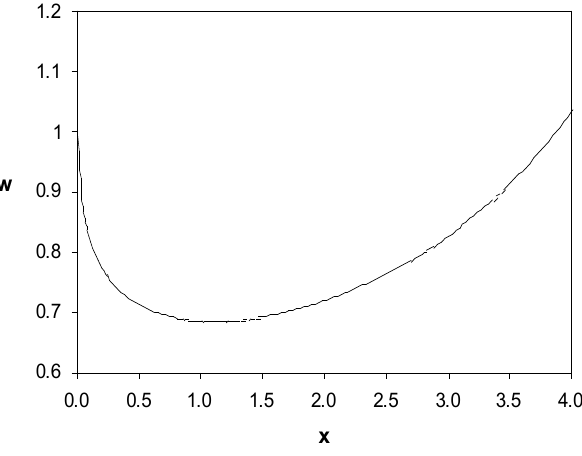
Fig. 4. Weighting factor applied to the two versions of the second term of exfiltration capacity